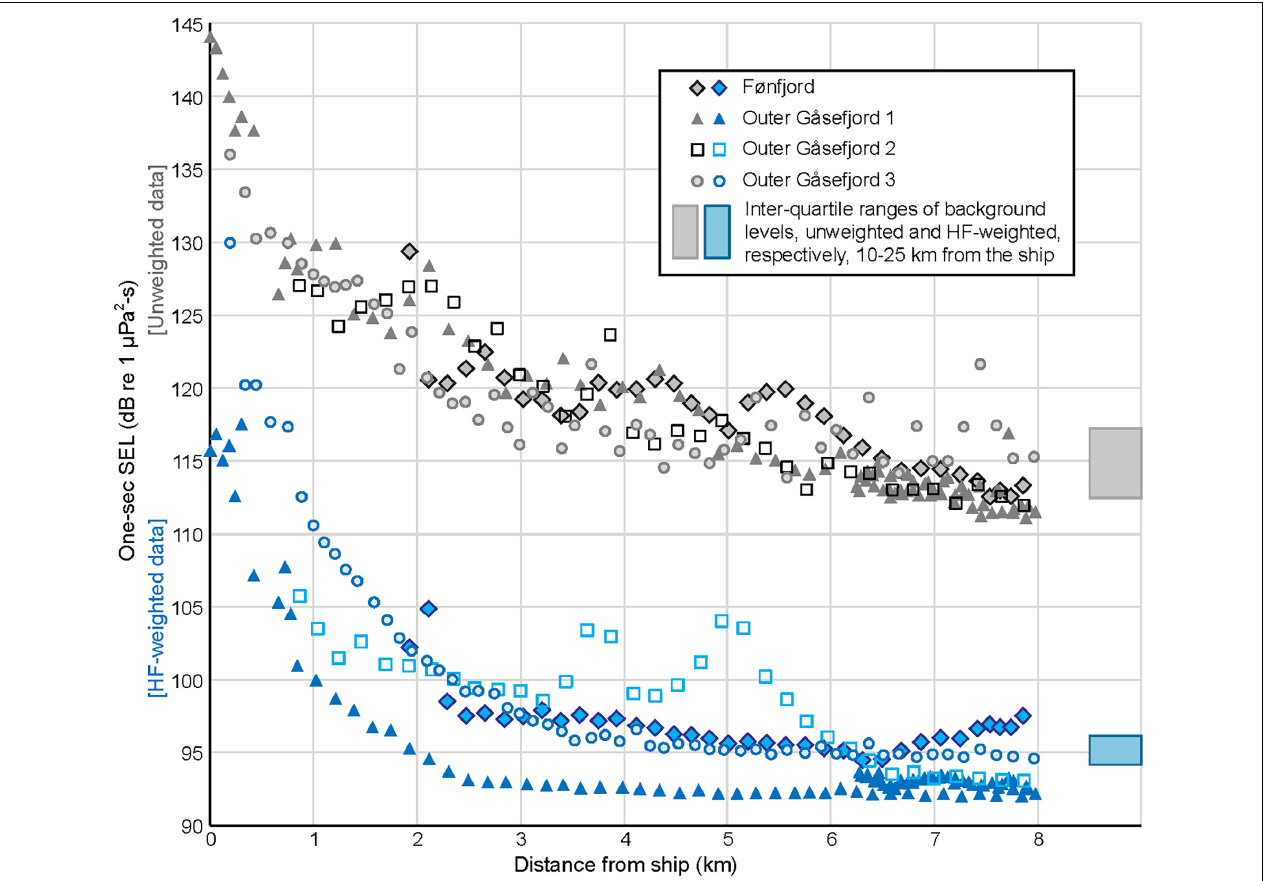
FIGURE 6 | Broadband (10 Hz–48 kHz) background levels, unweighted (gray symbols) and HF-weighted (blue symbols), as collected during the four SSVs in Fønfjord and Outer Gåsefjord. Sample length is 1 s, so the values also correspond to sound pressure levels (SPL, in dB re 1 µ Pa). For comparison, the blocks on the right edge of the plot show the interquartile range (25th–75th percentiles) of background values analyzed 10–25.5 km from the